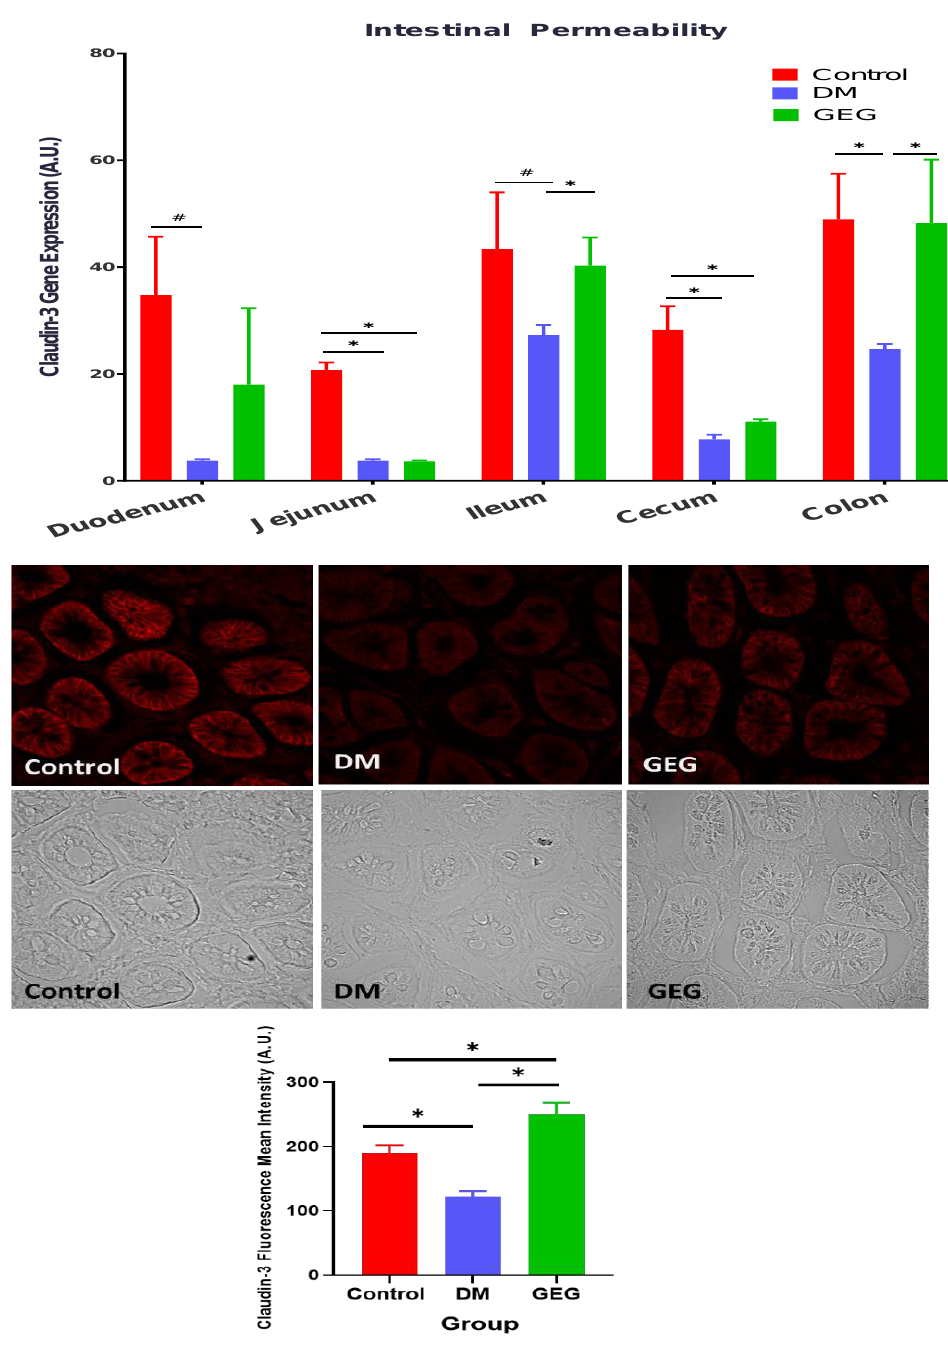
Figure 5. Effect of gingerol-enriched ginger (GEG) on mRNA gene expression of Claudin-3 in duodenum, jejunum, ileum, cecum, and colon of rats ( A ). Colon tissue sections were immunostained for Claudin-3 along with quantification of Claudin-3 fluorescence intensity ( B ). Data is expressed as mean ± SEM. n = 6 – 8 per group. Data was analyzed by one-way ANOVA followed by a post hoc Tukey’s test. * p < 0.05. # 0.05 < p < 0.1. IHC magnification 60×.